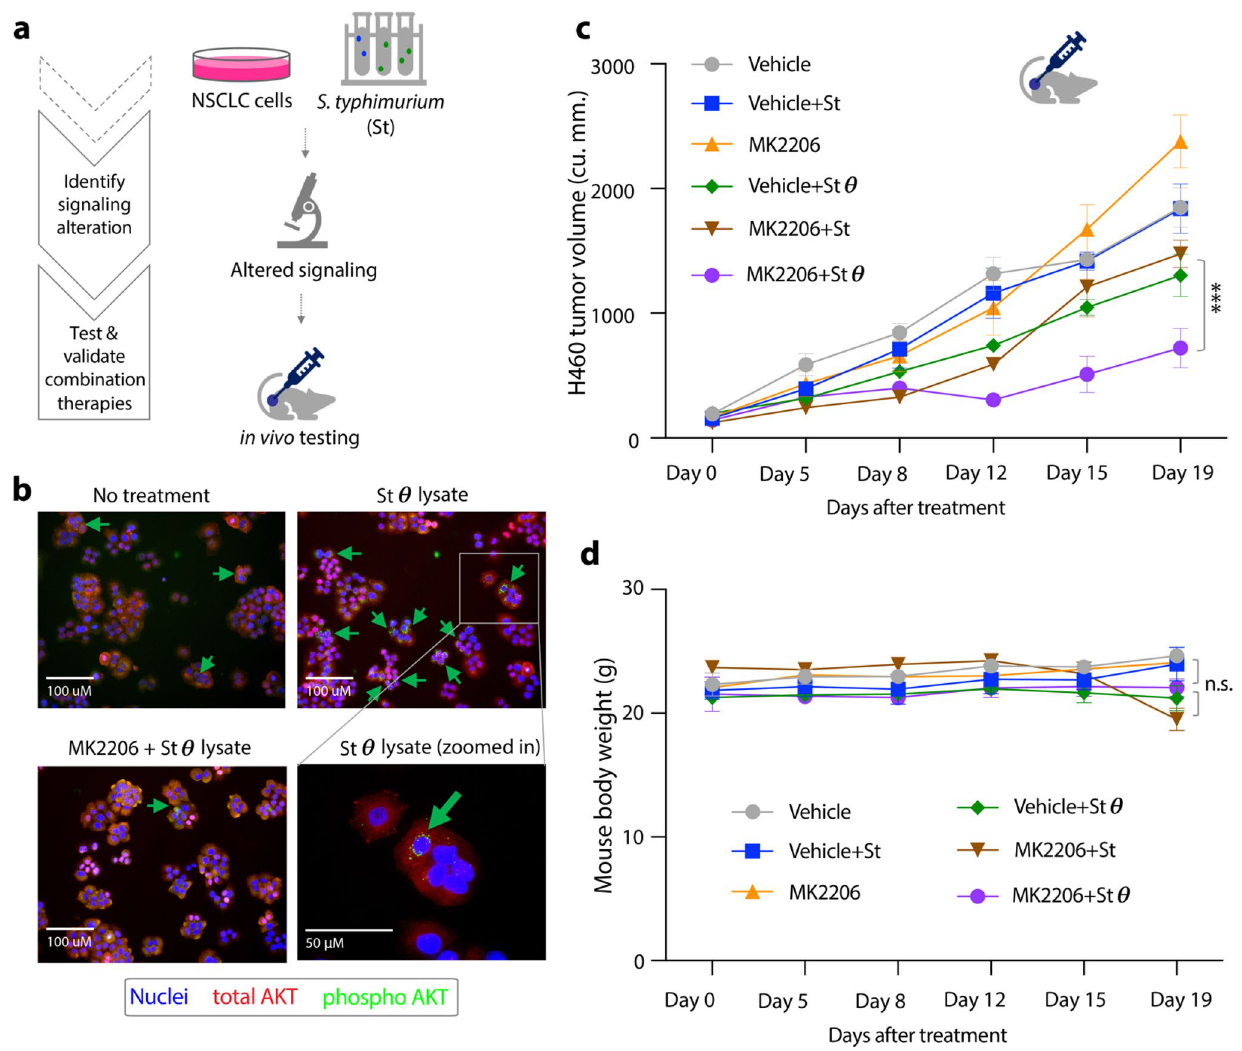
Figure 4. Combining AKT inhibitors and bacterial therapeutics for NSCLC therapy. ( a ) Schematic of the fourth part of the pipeline to validate the efficacy of one of the combination therapies. ( b ) AKT signaling in H460 cells upon θ toxin and MK2206 treatment: S. typhimurium was grown in presence of AHL to produce θ toxin and were lysed and filtered. H460 cells in monolayer were treated with θ toxin filtrate for 30 min, with or without 10 mM MK2206. Indirect immuno-fluorescence was carried out with antibodies against total AKT (red), phospho-AKT (Ser473) (green). Nuclei were stained with DAPI (blue). ( c ) Response of H460 subcutaneous tumors in NSG mice to 6 treatment cohorts (n = 3 or 4 per cohort): Vehicle, Vehicle + S. typhimurium producing GFP abbr. “St”, MK2206 targeting AKT, Vehicle + S. typhimurium producing both GFP and θ toxin abbr. “Stθ”, MK2206 + St, and, MK2206 + Stθ. Treatment began once tumors reached ~ 150 cu.mm. twice a week. Live Salmonella was injected intratumorally suspended in 40 μL of sterile 1 × DPBS (vehicle) with concentration of 4.5 X 10 7 CFU/mL followed by subcutaneous injection of AHL, a day after, to induce θ toxin secretion within the tumor. MK2206 drug was delivered by oral gavage as 240 mg/kg dose with 30% Captisol in 1 × DPBS as vehicle. Significant change in tumor size (*** = p < 0.001) was determined by two-way repeated ANOVA and error bars represent standard error. ( d ) Body weight of mice measured throughout the treatment schedule, error bars represent standard error (n = 3 or 4), n.s. = not